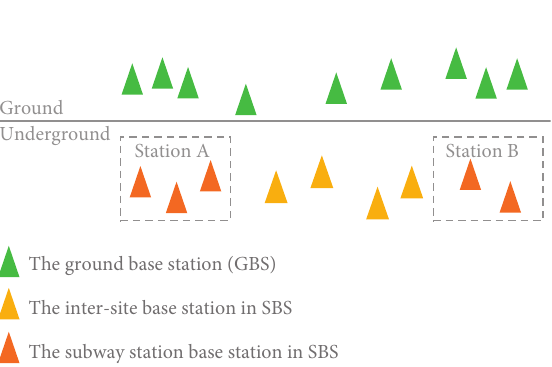
Figure 3: Base station